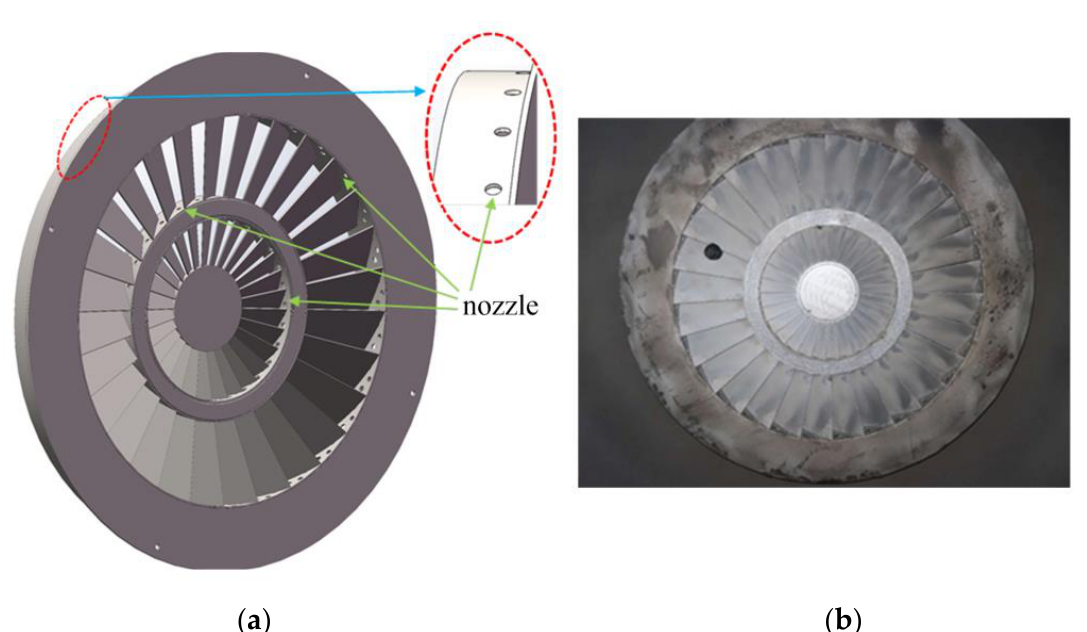
Figure 2. ( a ) Schematic structure of co-rotating swirler; ( b ) the swirler for the experiments.